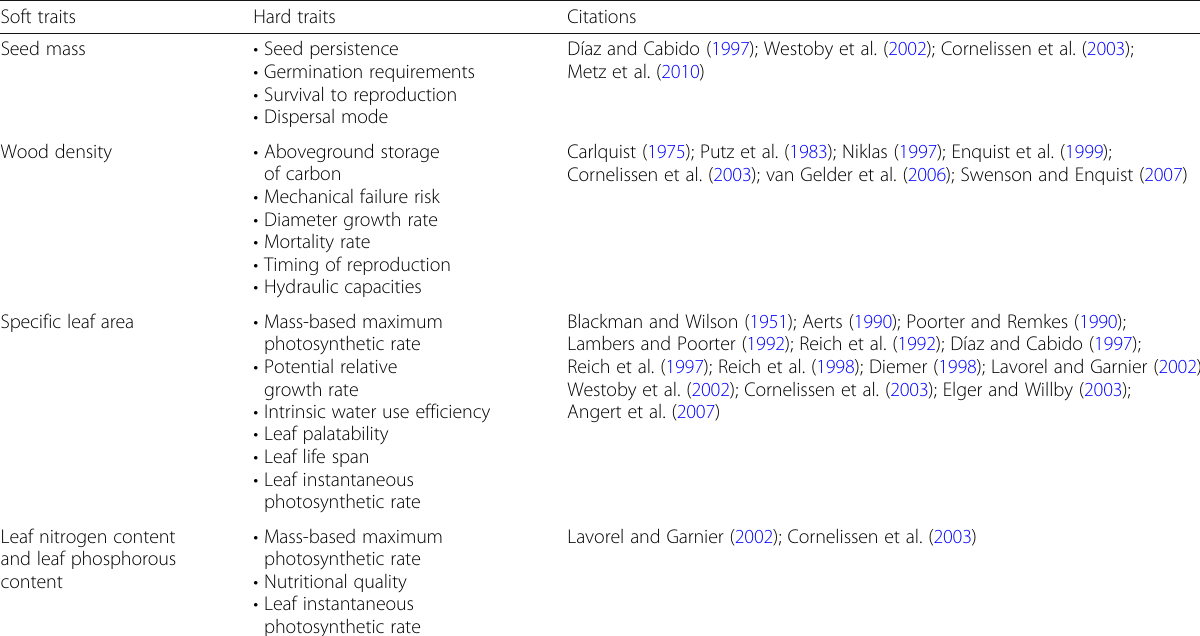
Table 1 The relationship between more easily measured “ soft functional traits ” and less easily measured, but potentially more informative, “ hard functional traits